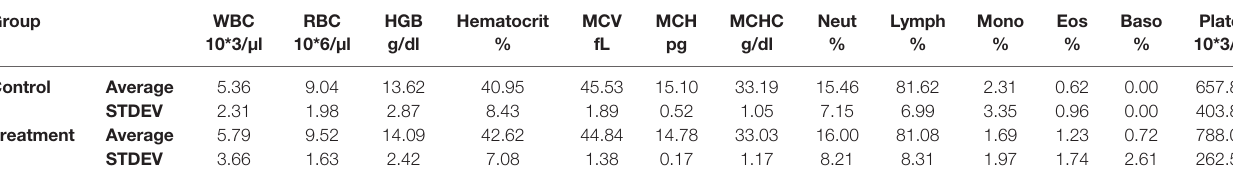
TABLE 3 | Average values of chemistry blood analysis results of mice at 25 weeks post treatment. Group Creatinine Phos Glucose Urea